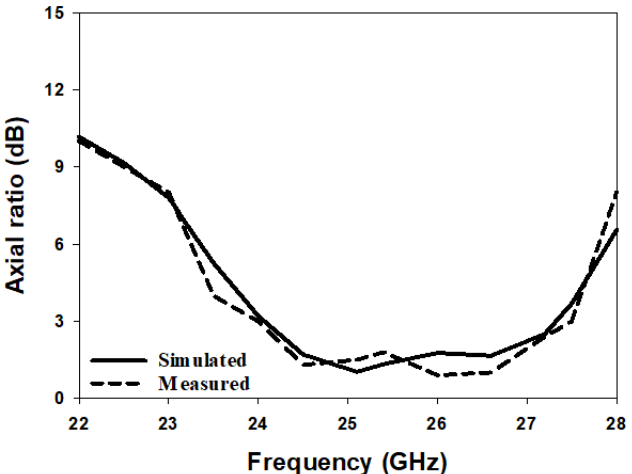
Figure 10. Reflection coefficient of a circularly polarised hemispherical DRA with added substrate between the DRA and feeding slot.